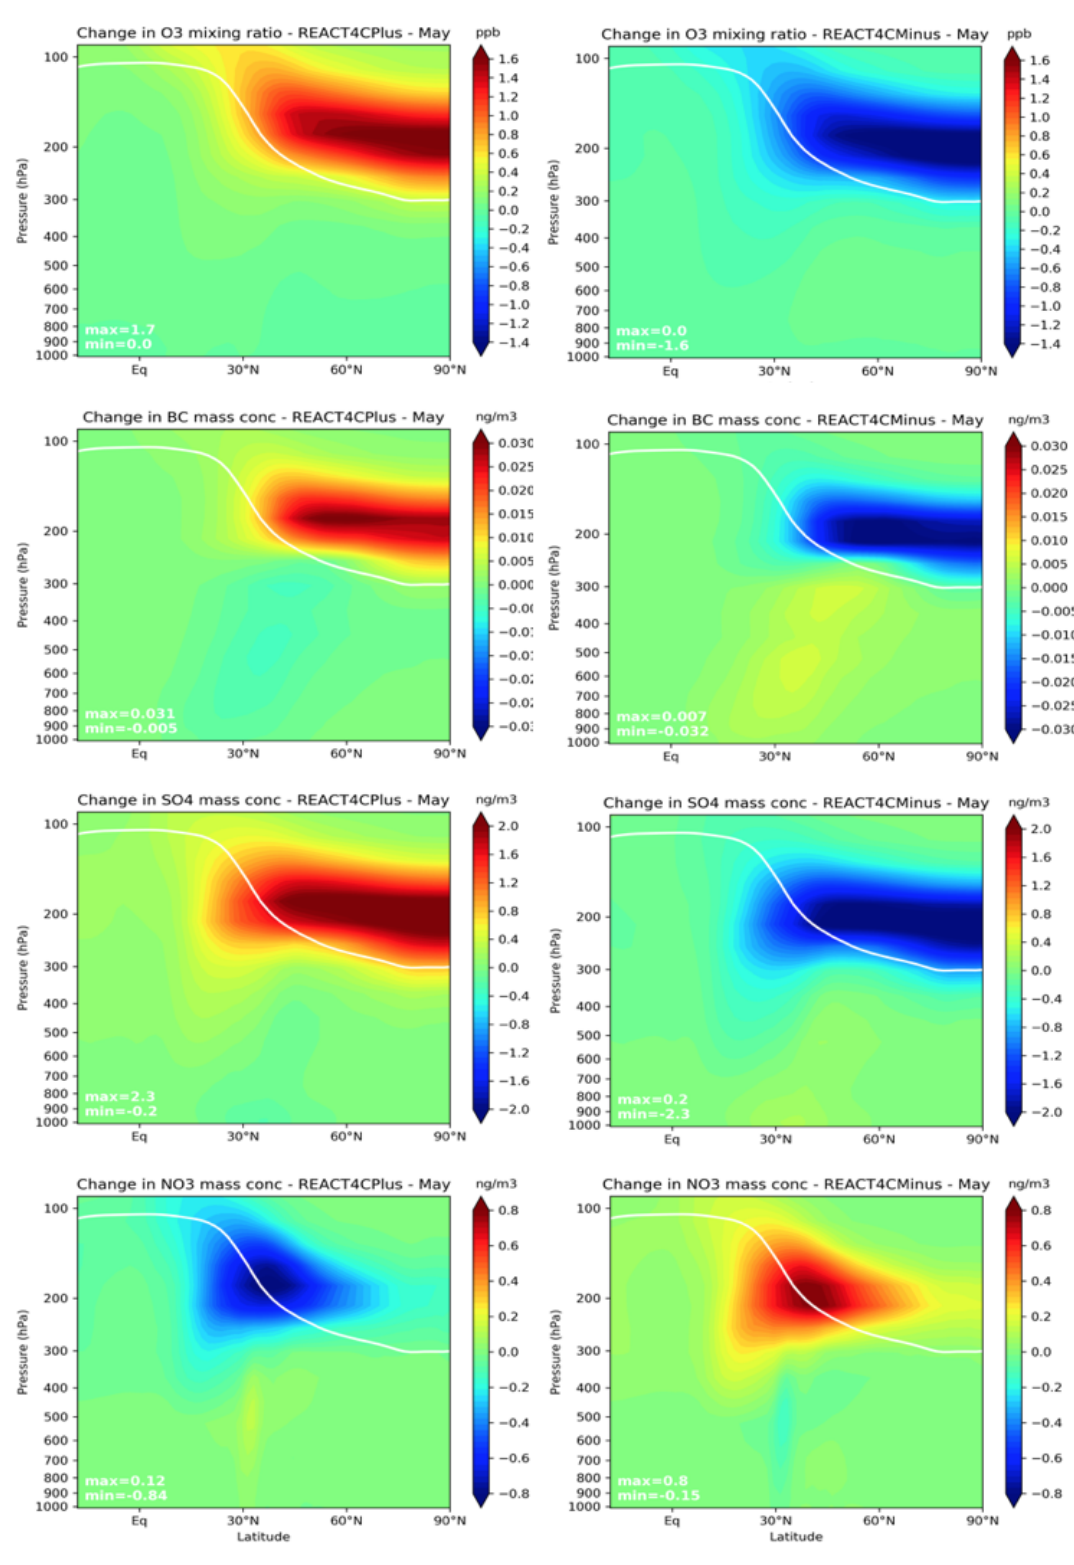
Figure 8. Zonal mean difference for the months of May for O 3 (ppbv), BC (ngm − 3 ), SO 4 (ngm − 3 ), and NO 3 (ngm − 3 ) between the REACT4C_PLUS (left) and REACT4C_MINUS (right) simulations and REACT4C_2006 as the reference. The solid line represents the tropopause